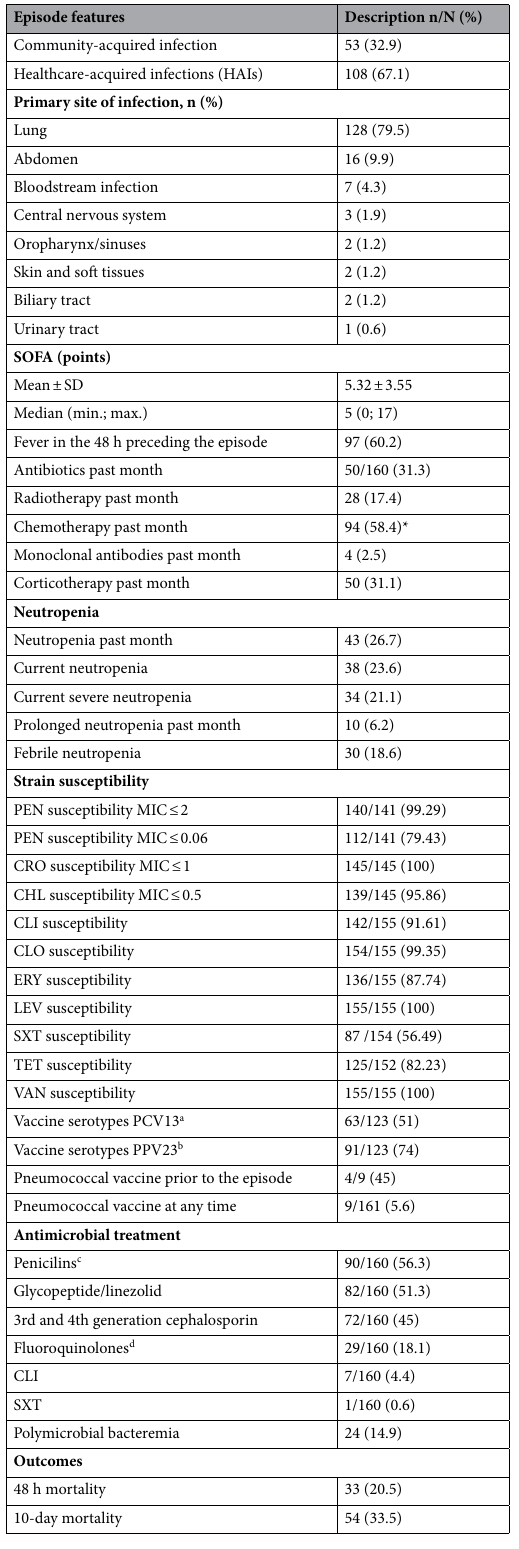
Table 2. Description of the characteristics evaluated in 161 episodes of bacteremia by Streptococcus pneumoniae in cancer patients. *Data available in only 74 of 94 episodes that mentioned prior